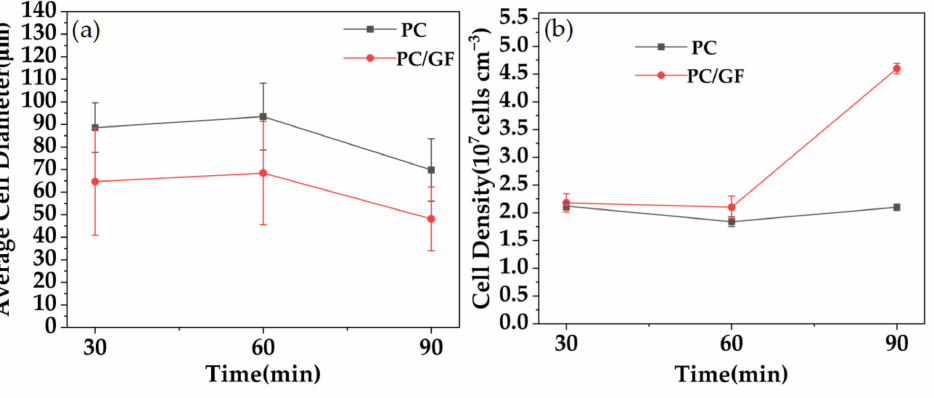
Figure 13. Pure PC and 15% GF loaded PC/GF at different saturation times: ( a ) changes in mean cell diameter and ( b ) changes in cell